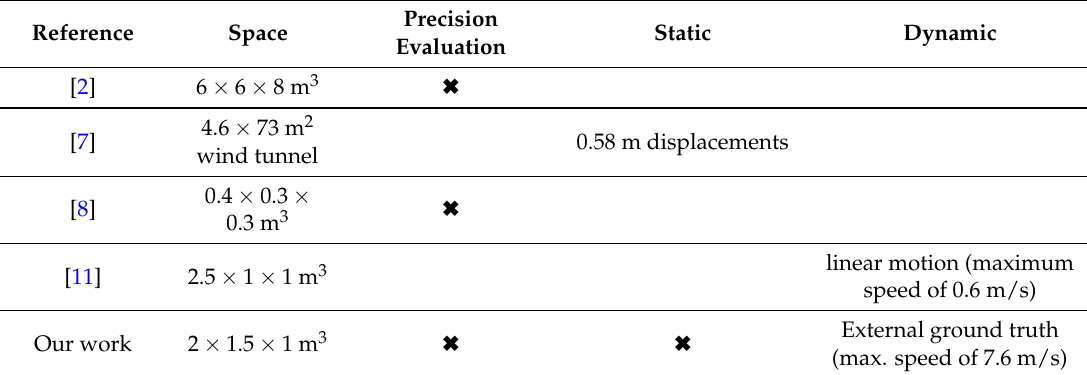
Table 1. Summary of existing Vicon evaluation studies.